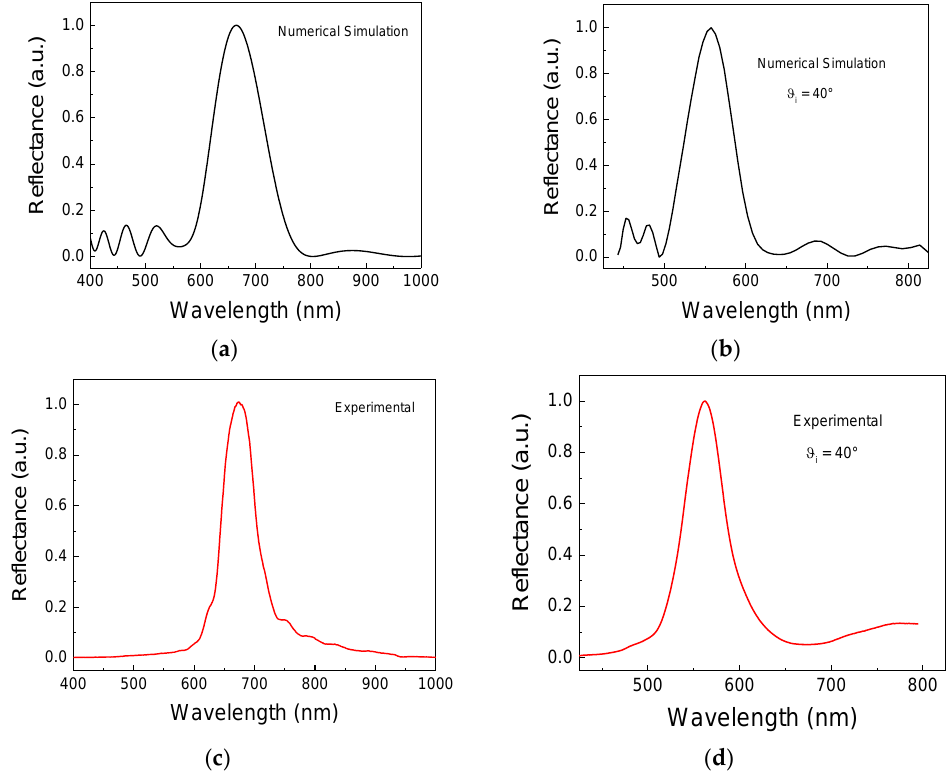
Figure 3. Simulated reflectance spectra ( a ) θ i = 0° and ( b ) at θ i = 40° obtained by the FDTD Software package. Experimental reflectance spectra at ( c ) θ i = 0° and ( d ) at θ i = 40°, respectively. θ i is the incident angle.